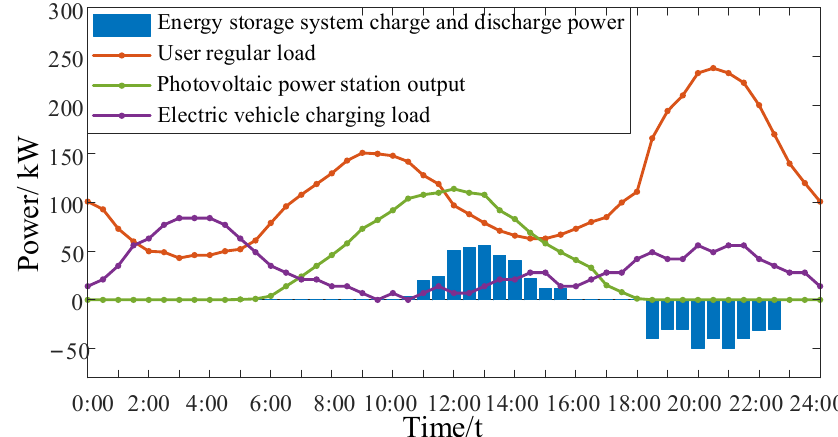
Figure 6. A-phase conventional load, photovoltaic generator output, battery output, and optimized electric vehicle charging load curve.